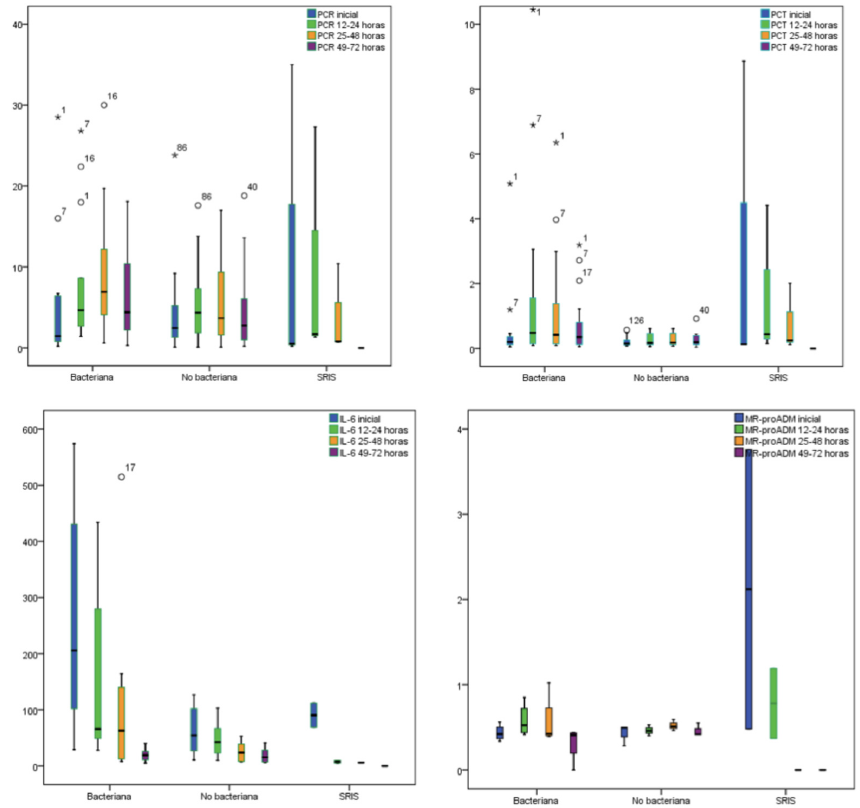
Figure 1. Box plot showing biomarker kinetics. Median and interquartile range are shown in the box. Range from minimum to maximum is represented with whiskers. CRP: C-reactive protein; PCT: procalcitonin; IL-6: interleukin-6; MR-proADM: midregional-pro-adrenomedullin. Table 3. C-Reactive Protein, Procalcitonin, IL-6 and MR-proADM levels in episodes with bacterial infection, systemic in- flammatory response syndrome, and no bacterial infection in the four analytical controls.